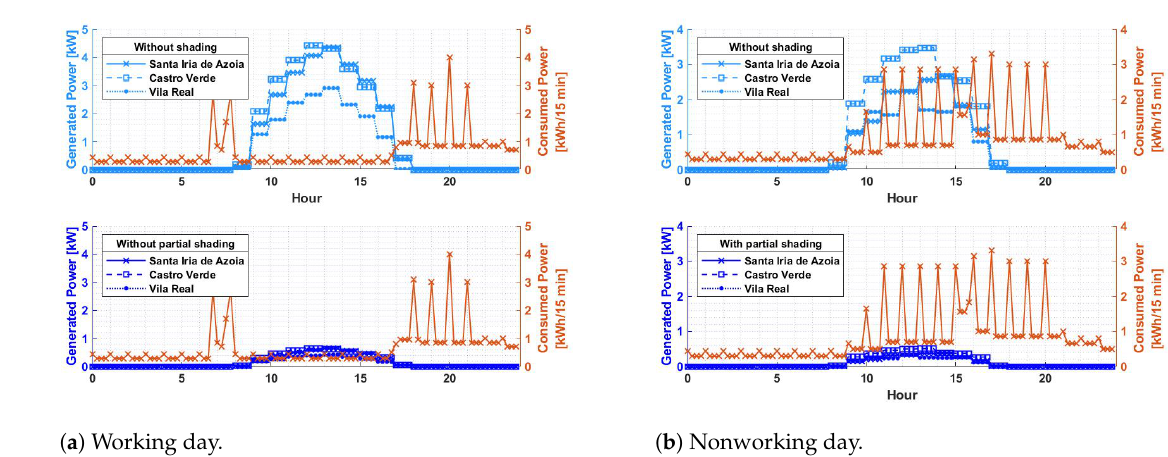
Figure 9. Generation and consumption curves on the two significant days of January for CsPbI 3 QDs